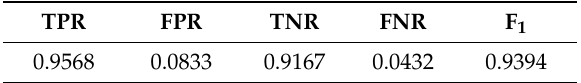
Figure 10. The AMoF and the fitted slope for di ff erent nodes for scenario NS1P3: ( a ) The AMoF for di ff erent NUT; ( b ) the fitted slope for NS1P3_BH_GM 25 / 5. Table 10. Performance characterization for NS1P3_BH_GM 25/5.